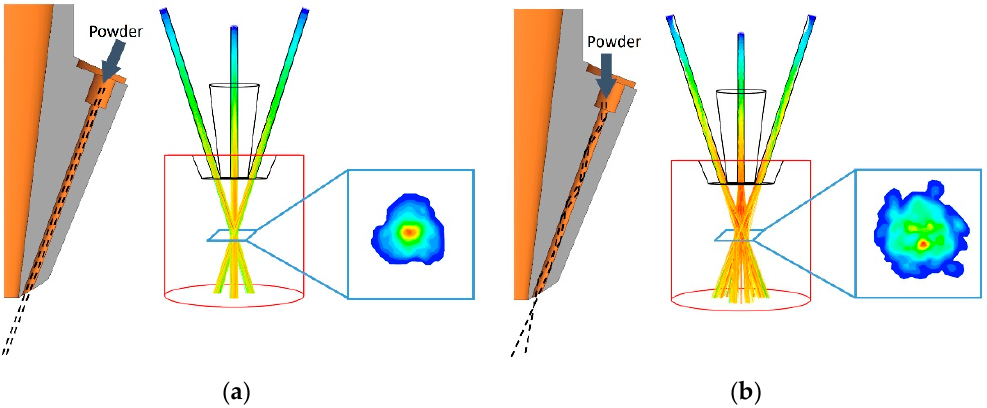
Figure 6. Schematic of powder incident direction and concentration distribution of powder stream for coaxial discrete nozzle. ( a ) The powder is parallel to the passage; ( b ) the powder is tilt to the passage.